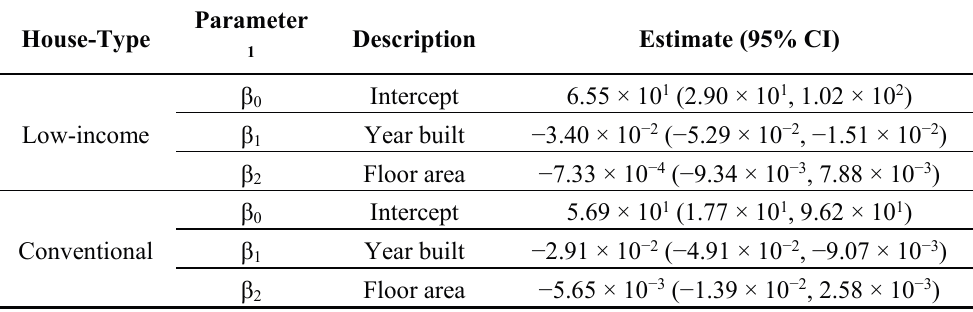
Table 2. Estimated leakage area model parameters for older homes (built in 1979 or before).